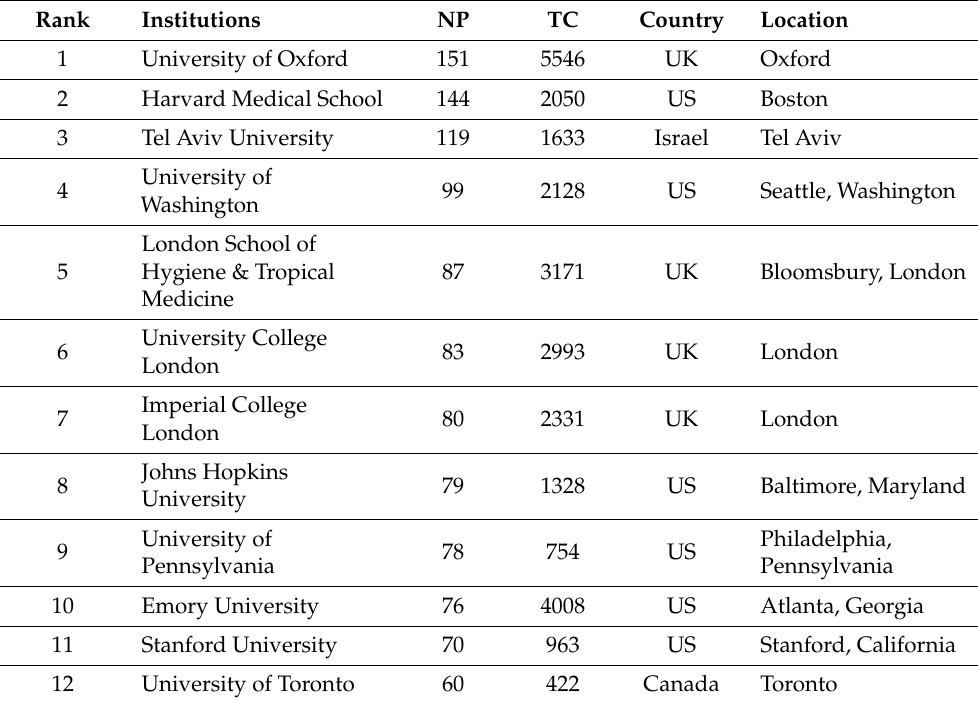
Figure 5. Institutional collaboration network in COVID-19 vaccine research. Table 2. The most prolific institutions in COVID-19 vaccine research.